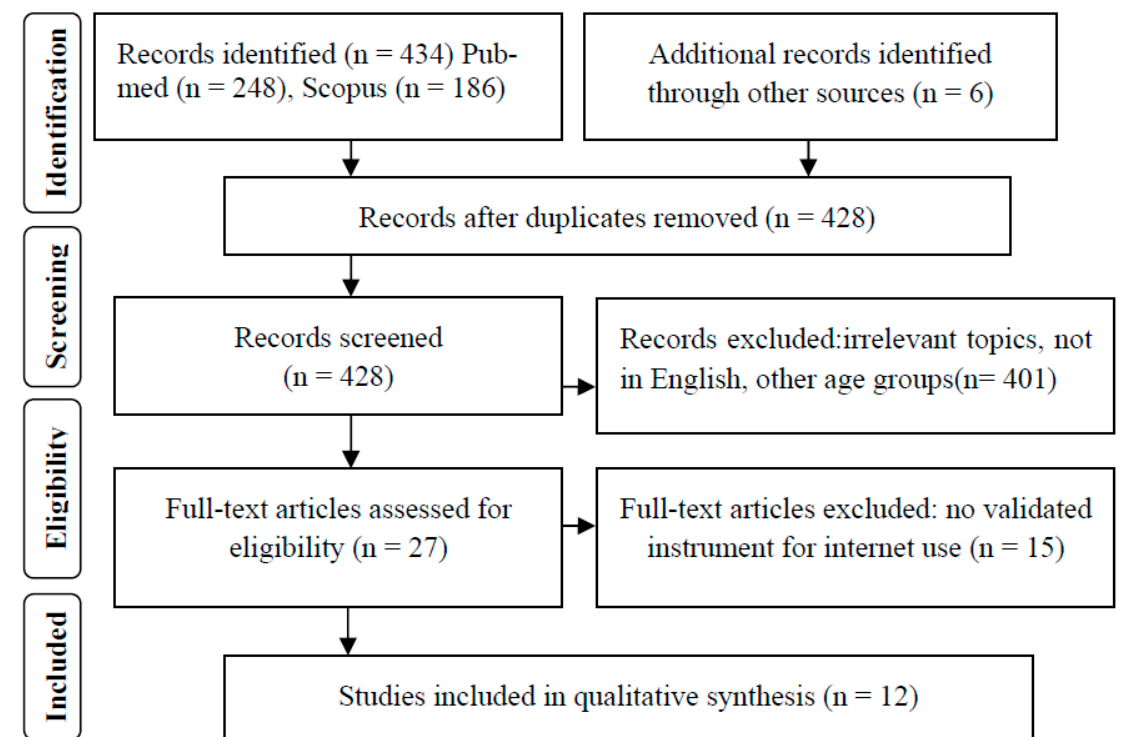
Figure 1. Flow chart of studies included in the review according to PRISMA guidelines.